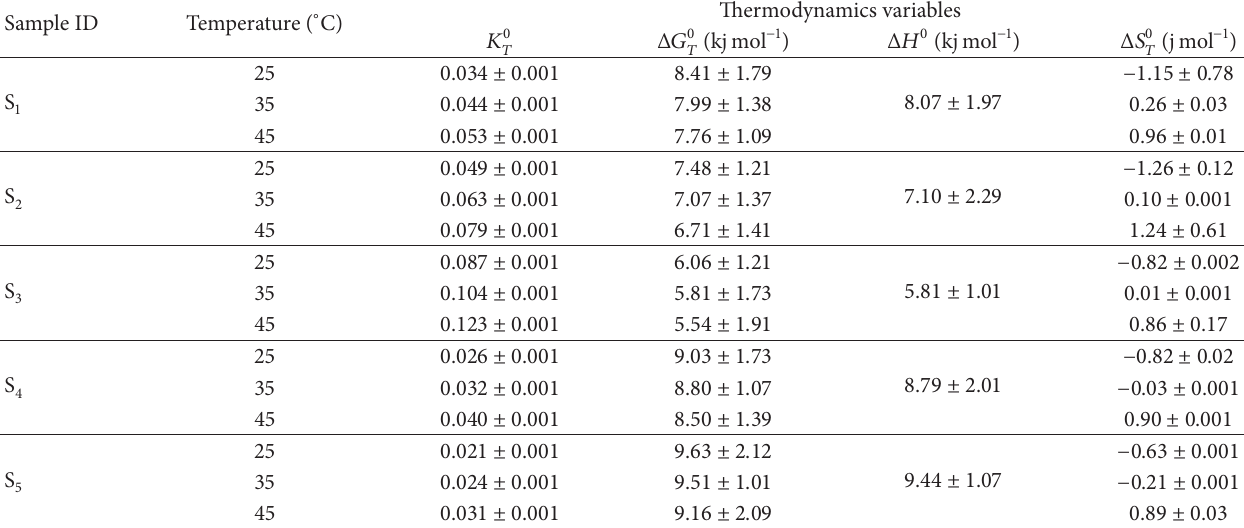
Table 5: Thermodynamics variables on Cd sorption at reaction temperatures on experimental soils (data represent mean of tree replications ±